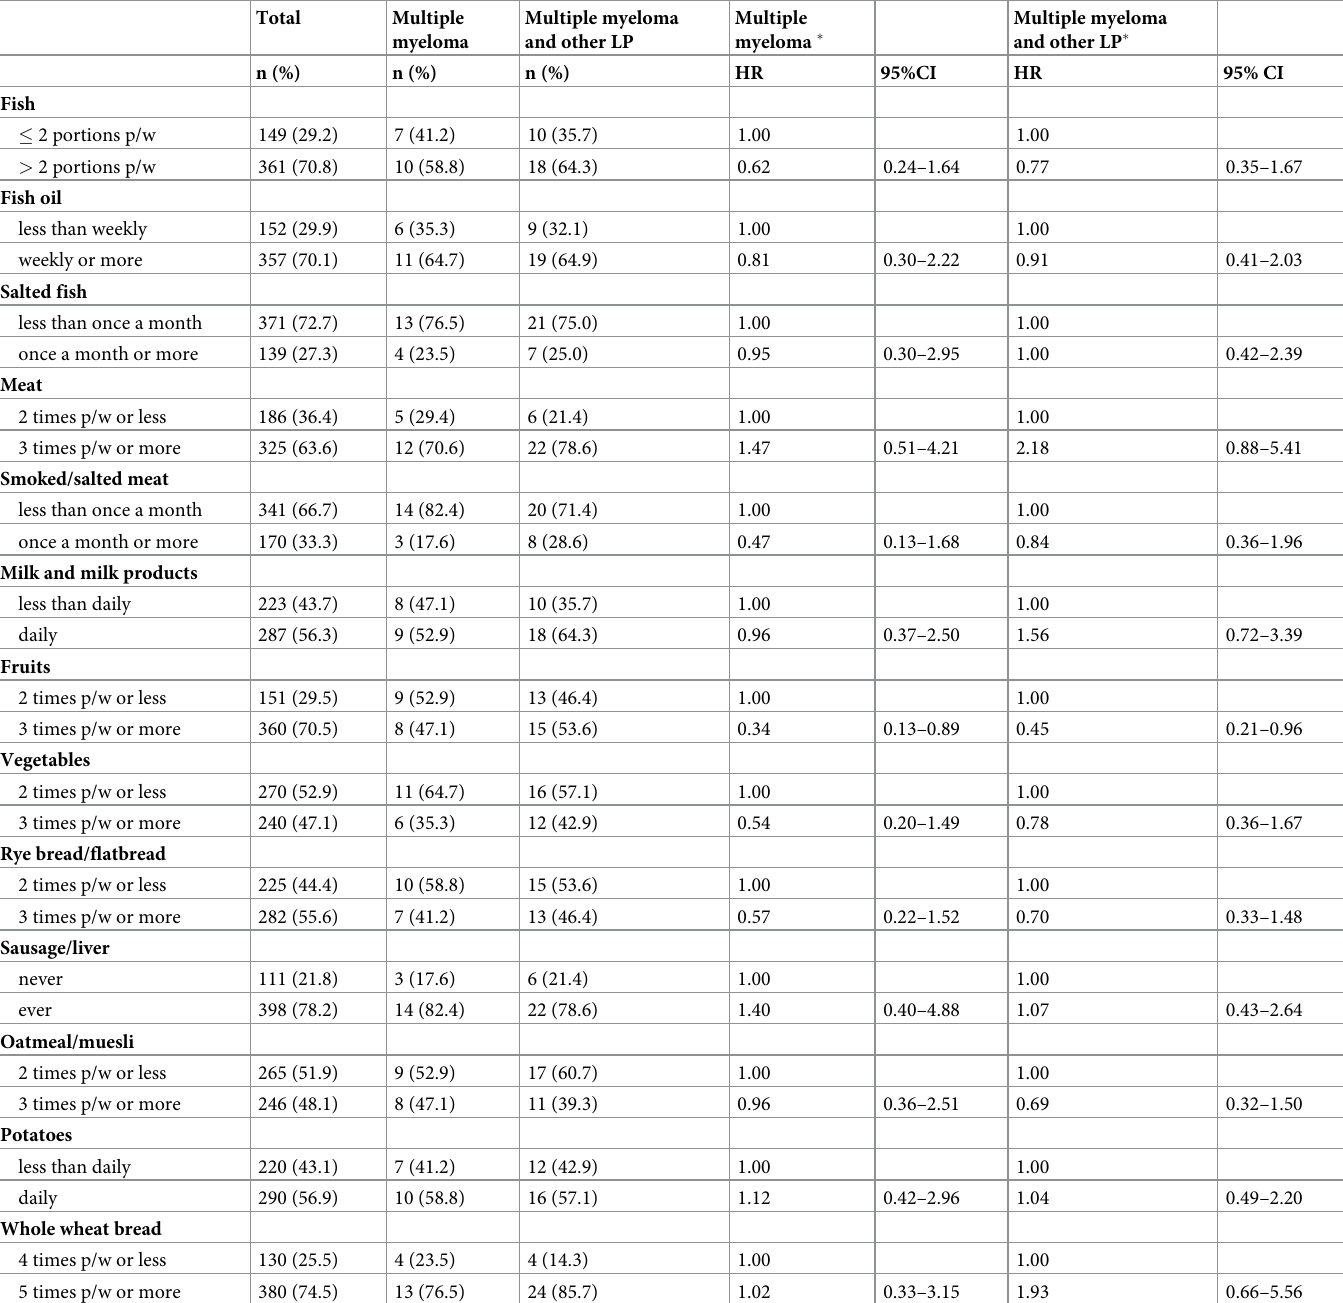
Table 4. The association between late life diet and risk of progression from MGUS and LC-MGUS to multiple myeloma and other lymphoproliferative diseases. Total Multiple Multiple myeloma Multiple myeloma and other LP myeloma